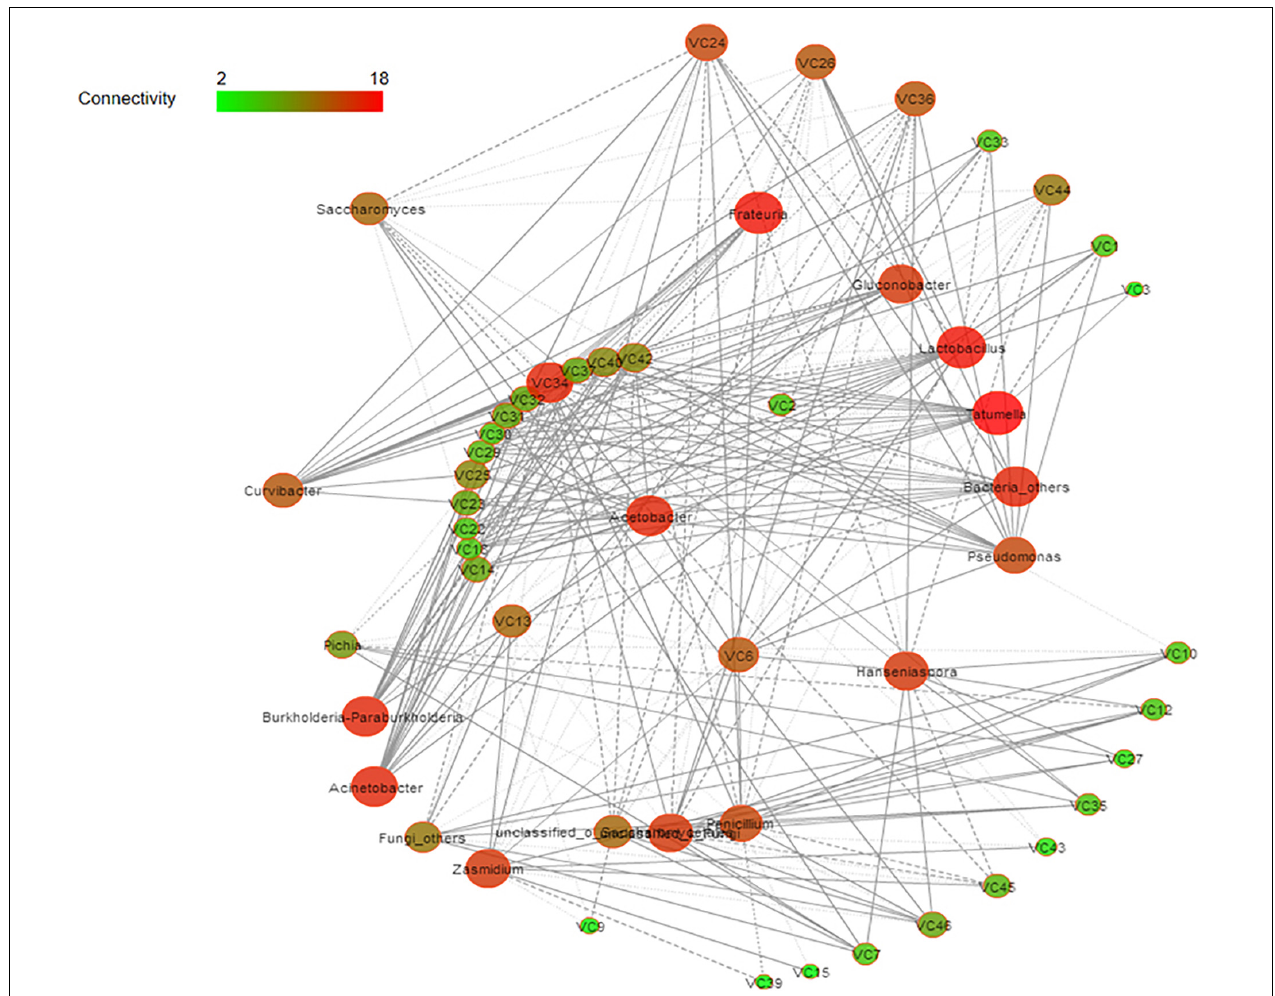
FIGURE 5 | Correlation network of co-occurring microbial genera in fermented grains. Statistically significant ( P < 0.05) Spearman correlation coefficient (| ρ | > 0.5) indicates the robust correlations. The size of nodes indicates the degree of connections. The same color of nodes indicates the same order. Edge thickness represents the proportional to the value of Spearman’s